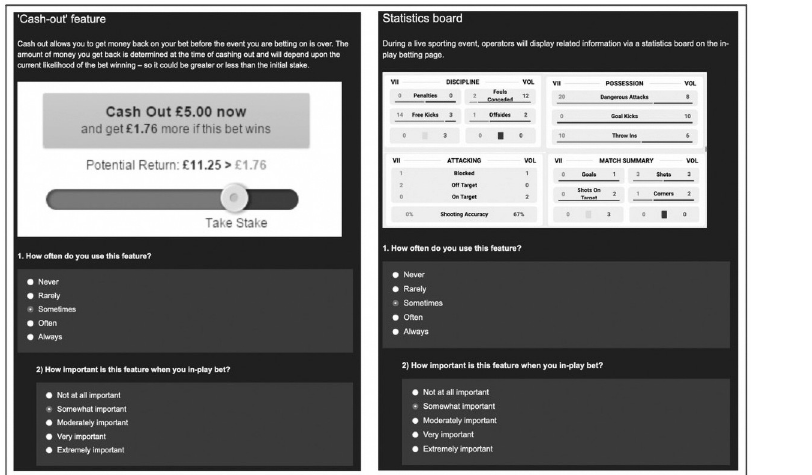
Fig 1. Screenshot examples of the in-play betting product feature